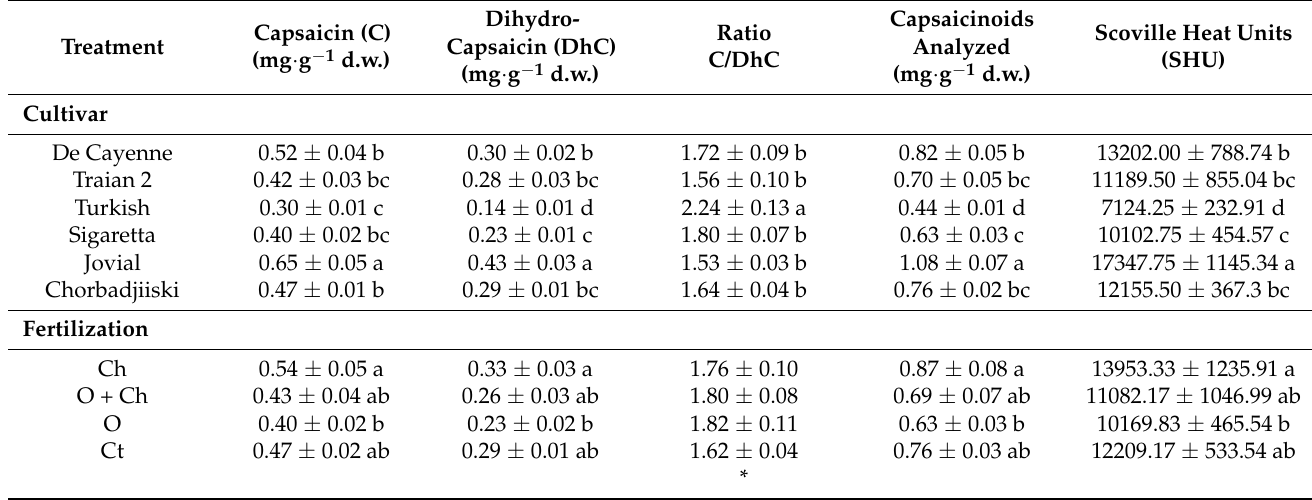
Table 4. Influence of cultivar and fertilization on capsaicinoid content and Scoville Heat Units.